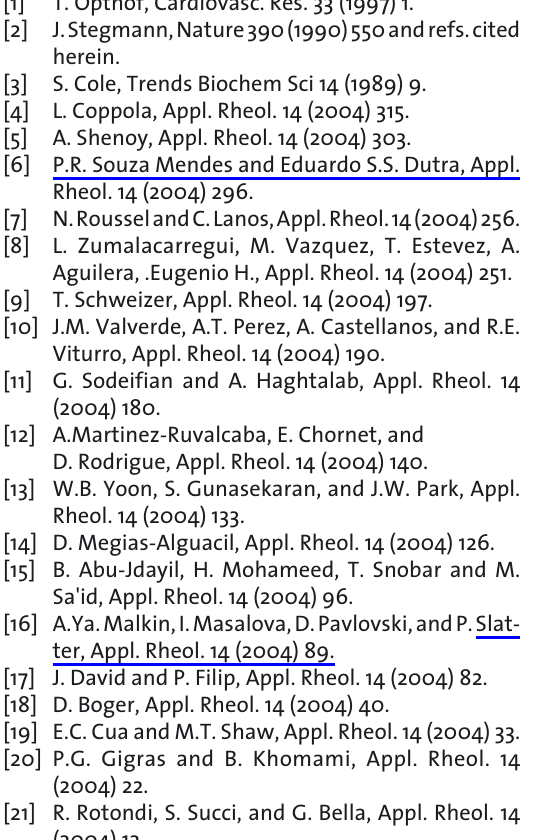
Fig. 3 (left above): Also the number of charac- ters in the abstract of scien- tific articles is not uncorre- lated with the CPY. Most abstracts have between 500 and 1500 characters, but papers with longer abstracts receive more attention. Again, the length of abstracts is also correlated with the length of the corre- sponding papers, and since the CPY is linear in the num- ber of article pages, it is fair to conclude that in an aver- age sense, each page of any of the rheological publica- tions receives quite a com- parable amount of atten- tion, i.e., citations. The mean number of title char- acters for all scanned publi- cations between 1990 and 2004 is 978. Fig. 4 (right above): The number of characters in the title of an article has lit- tle effect on the impact of an article. Exceptions are articles with titles below 30 characters which are very rare, but tend to receive a great attention. Notice the comparable poor statistical quality for papers with short titles, quantified through the plot. The mean number of title characters for all scanned publications between 1990 and 2004 is 73.7. Fig. 5 (left below): The number of authors has a large influence on the CPY, while the CPY per author clearly has its maximum at papers written by a single author. The mean number of authors for all scanned publications between 1990 and 2004 is 2.65. Fig. 6 (right below): CPY versus year of publica- tion revealing the ‘dynam- ics’ of citations. In the first few years after publication, the CPY is small compared to its long-time average. Also shown are the number of articles published in the 15 years time